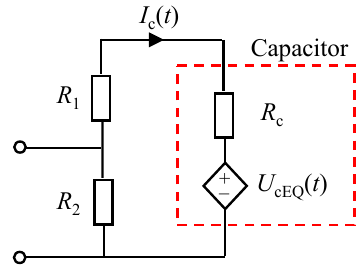
Figure 3. Detailed equivalent model (DEM) of each submodule of the